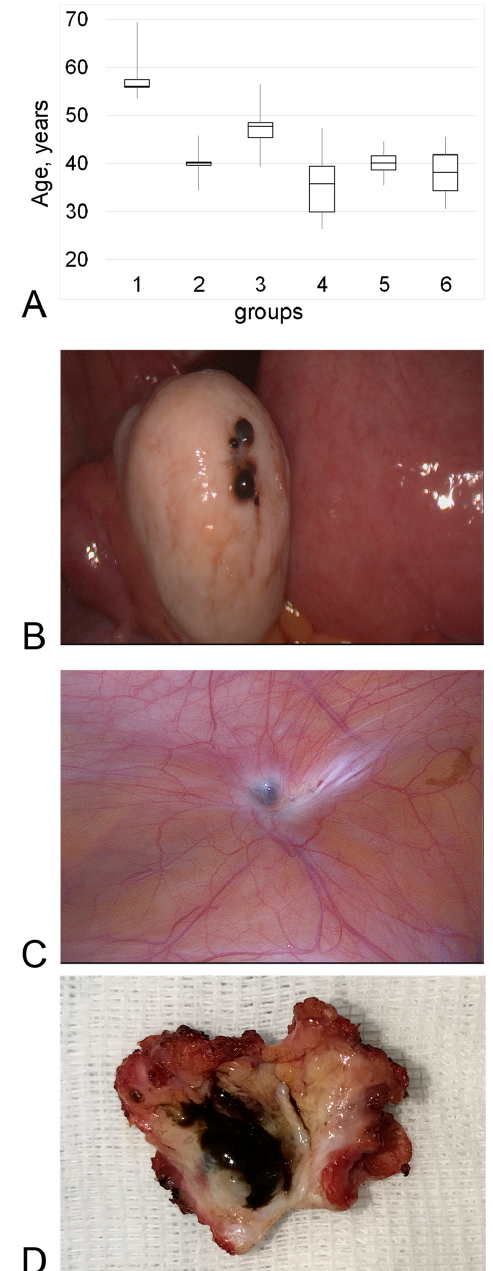
Figure 1. Comparison of groups. ( A )—Average age. ( B )—Typical intrasurgery picture of the endometrioid ovarian cyst (group 4—genital endometriosis). ( C )—Typical intrasurgery picture of the ectopic endometrium localized on the mesothelium (group 5—extragenital endometriosis). ( D )—postsurgery picture of the umbilicus with a focus of ectopic endometrium. All pictures were taken by Konstantin A. Toniyan during surgery with the informed consent of the patient.